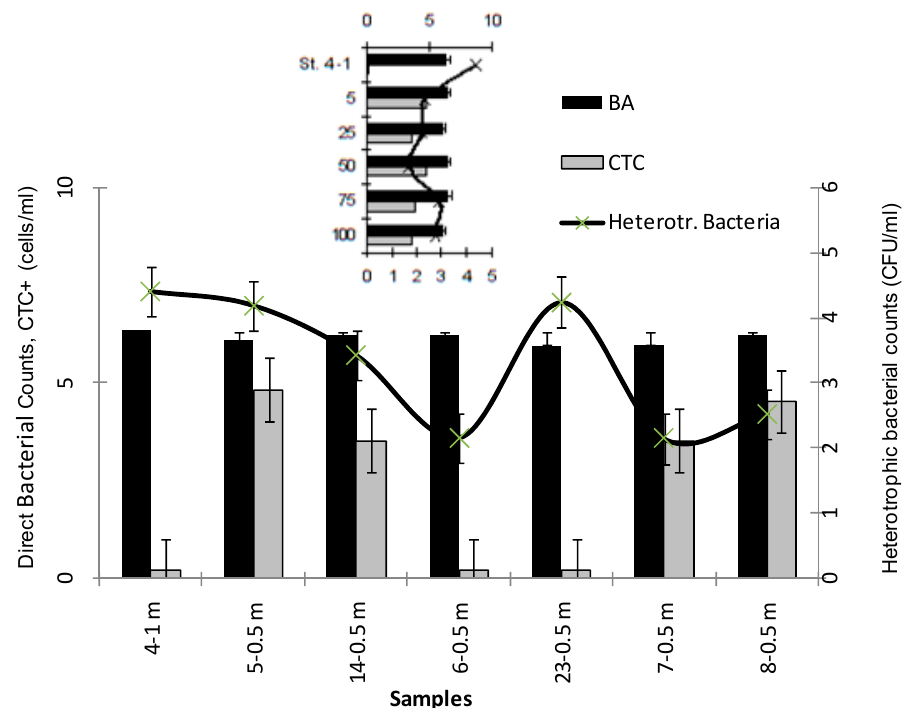
Figure 5. ( a ) Absorption coefficients measured in the study area; ( b ) vertical profile of the absorption coefficient obtained at a 400 nm wavelength at station 4.